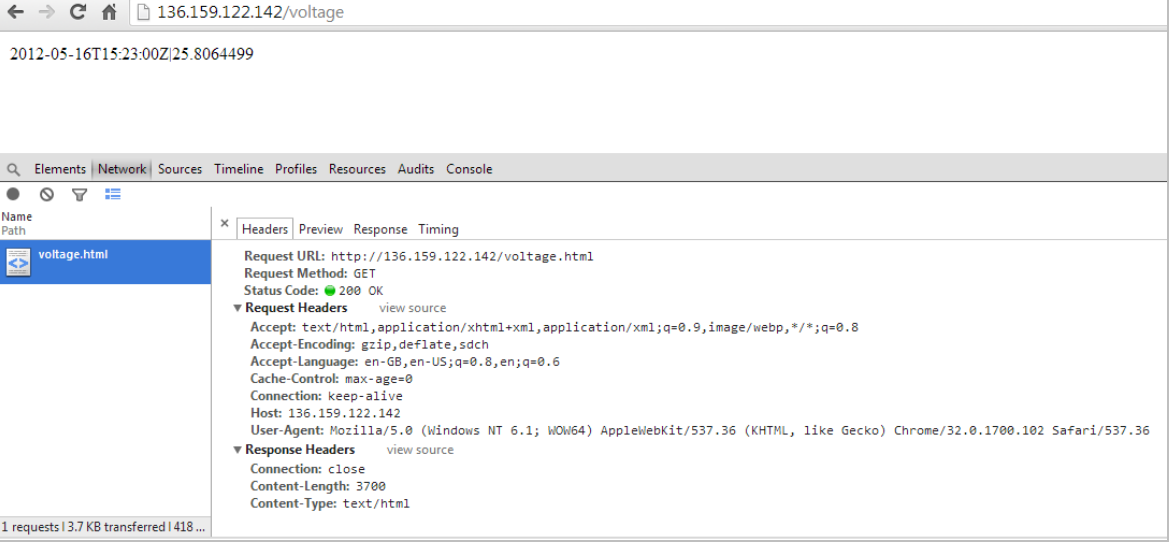
Figure A1. HTTP GET request and response to the simple web server through the